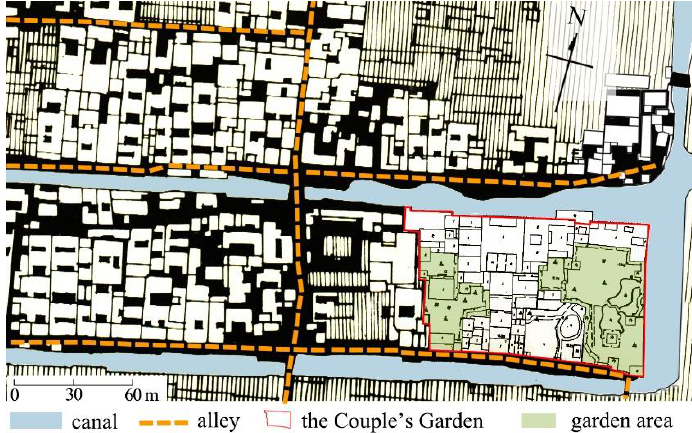
Figure 9. The Couple’s Garden and the typical urban fabric of Suzhou.